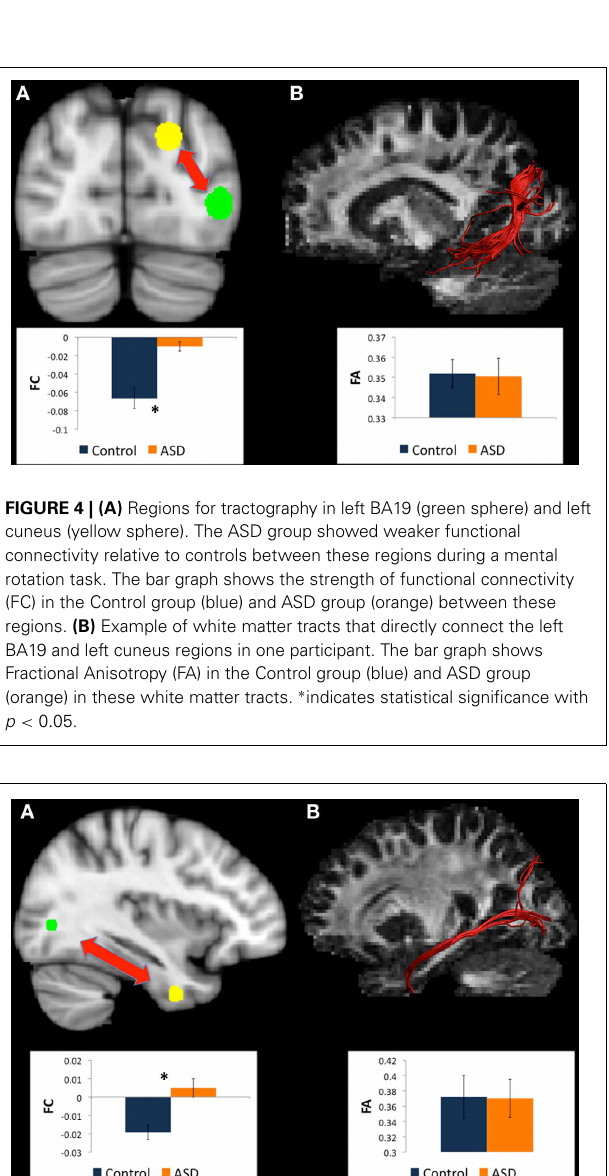
FIGURE 5 | (A) Regions for tractography in left BA19 (green sphere) and left uncus (yellow sphere). The ASD group showed weaker functional connectivity relative to controls between these regions during a mental rotation task. The bar graph shows the strength of functional connectivity (FC) in the Control group (blue) and ASD group (orange) between these regions. (B) Example of white matter tracts that run through the left BA19 and left uncus regions in one participant. The bar graph shows Fractional Anisotropy (FA) in the Control group (blue) and ASD group (orange) in these white matter tracts. ∗ indicates statistical significance with p < 0 .